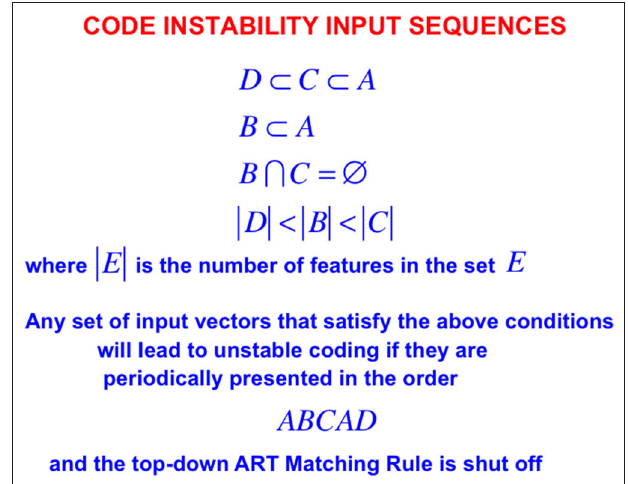
FIGURE 5 | When the ART Matching Rule is eliminated by deleting an ART circuit’s top-down expectations from the ART 1 model, the resulting competitive learning network experiences catastrophic forgetting even if it tries to learn any of arbitrarily many lists consisting of just four input vectors A, B, C, and D when they are presented repeatedly in the order ABCAD, assuming that the input vectors satisfy the constraints shown in the figure [adapted with permission from Carpenter and Grossberg